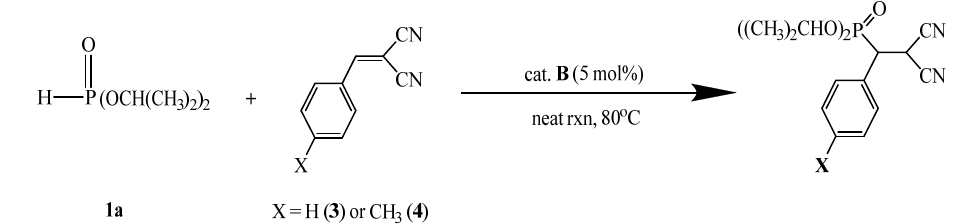
Table 7. Recycling results of B -catalyzed phospha-Michael addition of diisopropyl phosphite ( 1 ) with 2-benzylidenemalononitrile ( 3 ) at 80 °C.